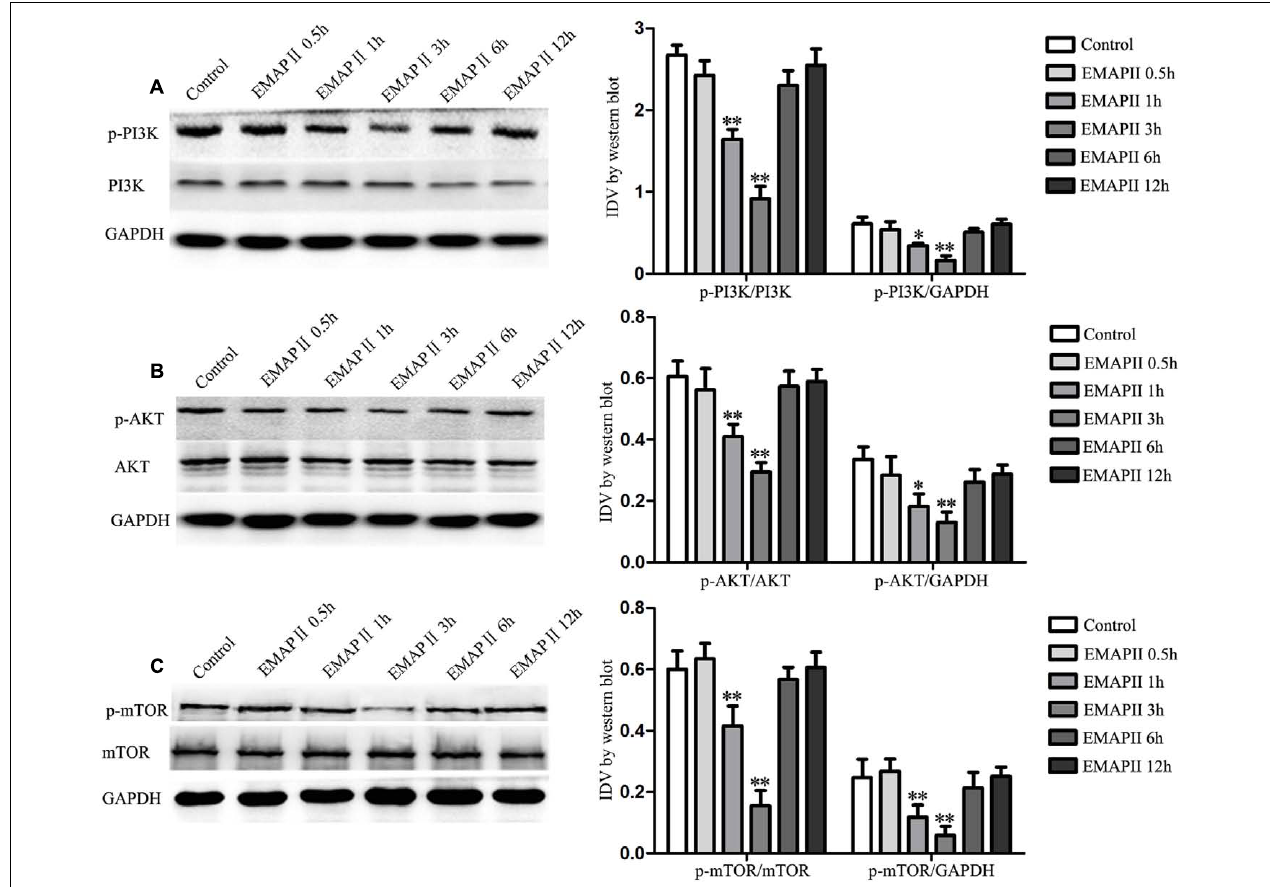
FIGURE 4 | Effect of EMAP II on the expression of PI3K, Akt, and mTOR in GECs. Western blot analysis was performed to evaluate the expression of (A) p-PI3K/PI3K, p-PI3K/GAPDH, (B) p-Akt/Akt, p-Akt/GAPDH, (C) p-mTOR/mTOR and p-mTOR/GAPDH after GECs treated with 0.05 nM EMAP II for 0.5, 1, 3, 6, and 12 h. Data represent means ± SD ( n = 5, each). ∗ P < 0.05 and ∗∗ P < 0.01 vs. control